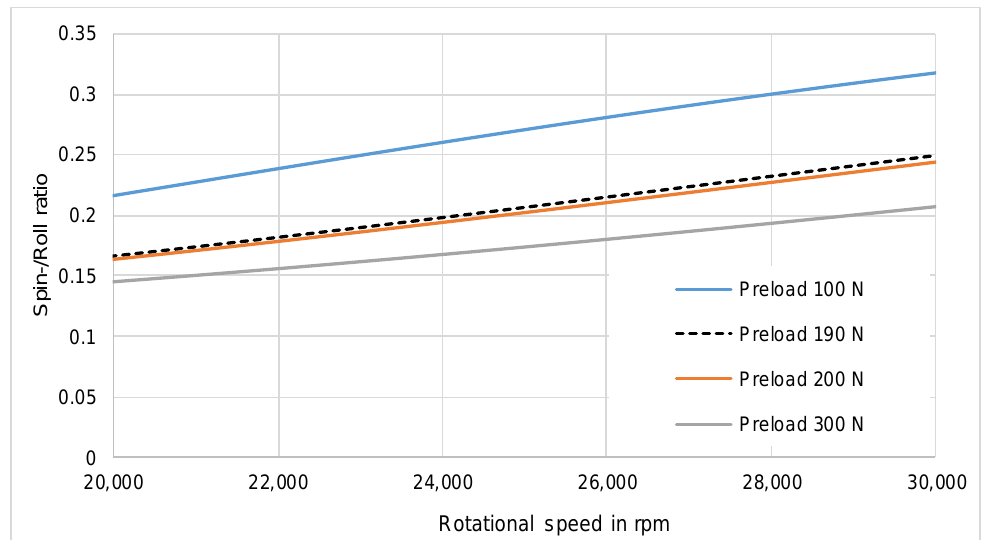
Figure 16. Spin-/Roll ratio of an axially spring preloaded angular contact spindle bearing between 20,000 rpm and 30,000 rpm — Simulation conducted with MESYS Shaft (Version 07-2019, MESYS AG, Zürich).